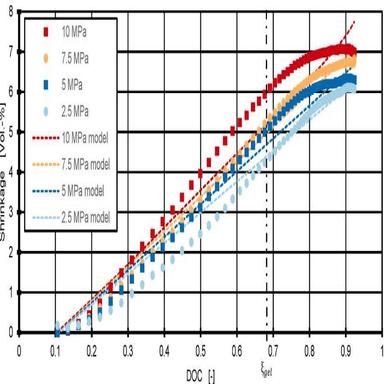
Pressure and DOC (via DSC) dependent chemical shrinkage for isothermal cure under 100 ◦C.